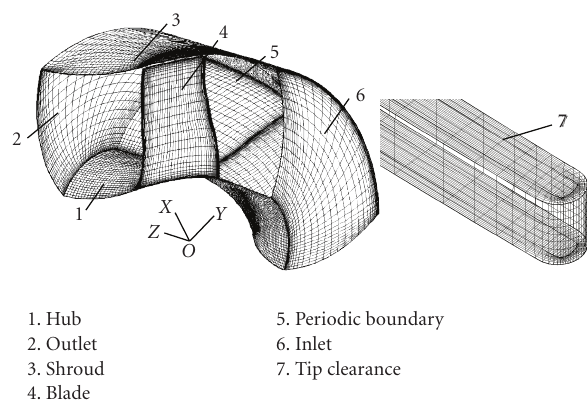
Figure 6: Computational